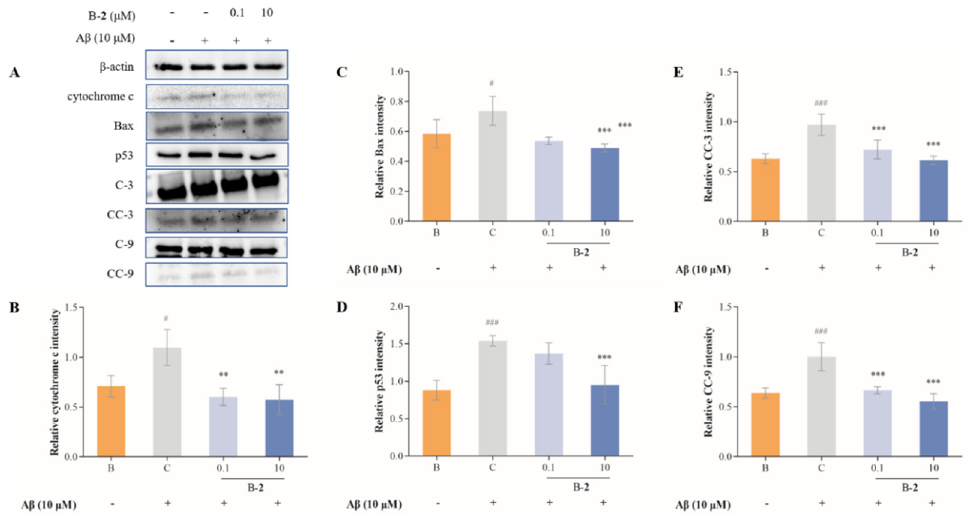
Figure 7. ( A ) Immunoblotting results of cytochrome c, Bax, p53, caspase − 3, cleaved caspase −